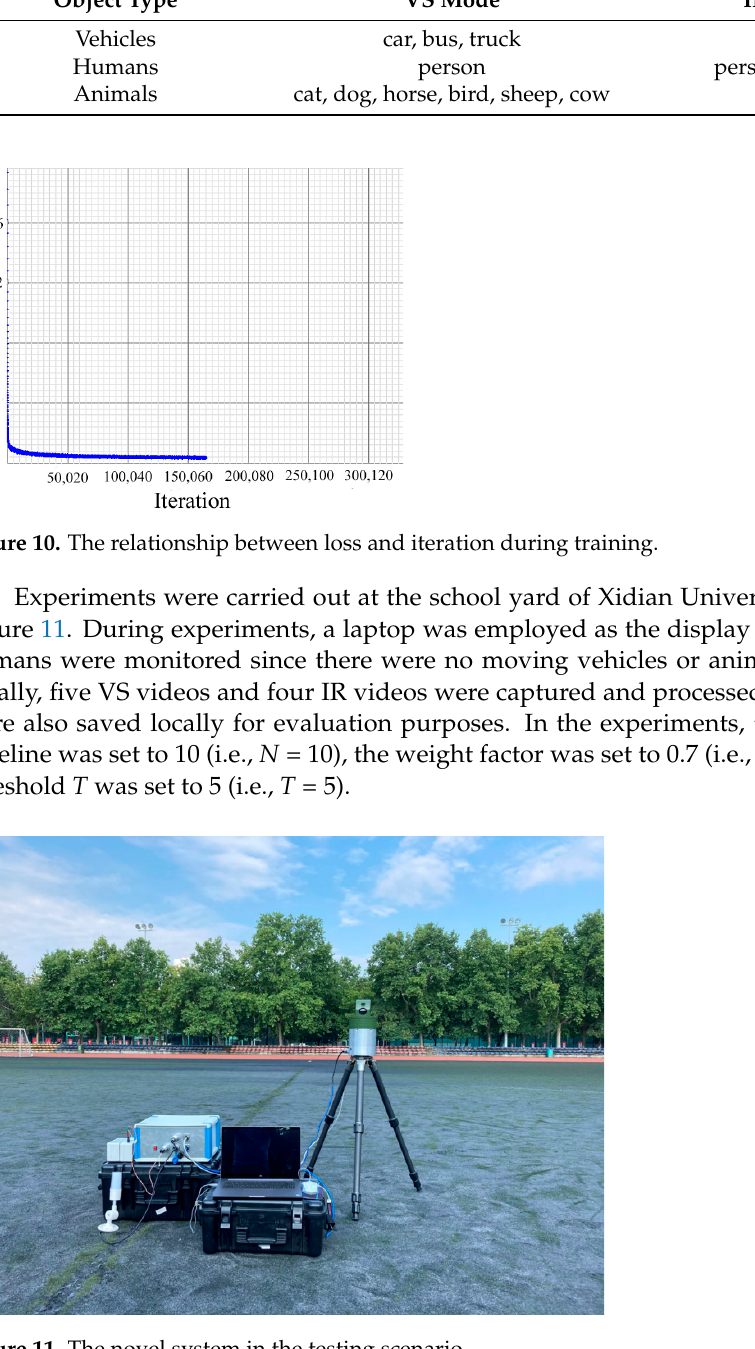
alarm rates are between 82.5% and 87.37%, the false alarm rates are equal to or less than 1.2%, and the missed alarm rates are between 12.63% and 17.95%. The reason why the false alarm rate is extremely low is that some false detection obtained in single frames was removed by the